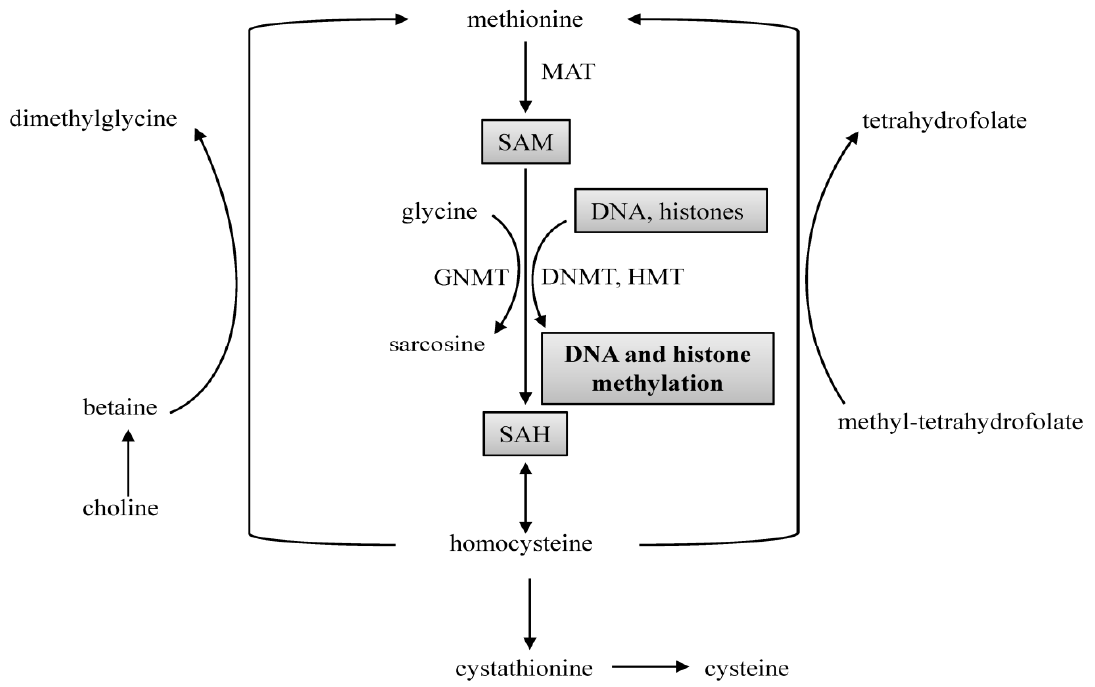
Figure 1. One-carbon